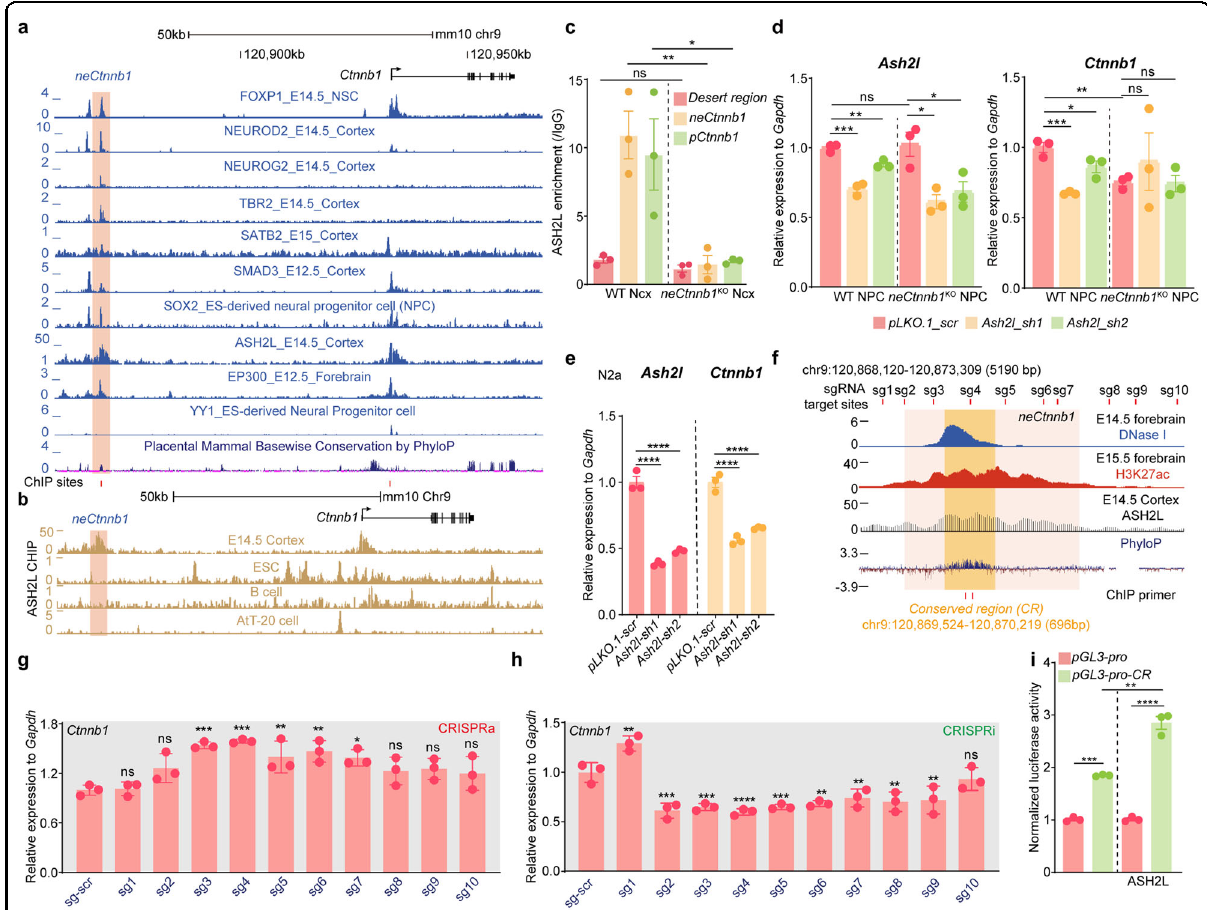
Fig. 5 ASH2L associates with neCtnnb1 and pCtnnb1 to regulate Ctnnb1 ’ s transcription. a ChIP-seq tracks for enrichment of indicated trans - acting factors in neCtnnb1 in developing Ncx. neCtnnb1 is highlighted. b ChIP-seq tracks for ASH2L in indicated murine cells. neCtnnb1 is highlighted. c ChIP-qPCR of E15.5 WT and neCtnnb1 KO Ncx using an anti-ASH2L antibody. n = 3 for WT Ncx and n = 3 for neCtnnb1 KO Ncx. Each point represents an individual brain. d RNA levels of Ash2l (left) and Ctnnb1 (right) in WT and neCtnnb1 KO neocortical NPCs transfected with indicated vectors for two days. NPCs were derived from E12.5 Ncx. n = 3 for WT brains and n = 3 for neCtnnb1 KO brains. Each point represents an individual brain. e RNA levels of Ash2l (left) and Ctnnb1 (right) in Neuro-2a cells transfected with indicated vectors for two days. Each point represents an independent experiment. f Schematic representation the location of neCtnnb1 (pink shading) and conserved region (orange shading) marked by enrichment of H3K27ac, DNase I hypersensitivity and ASH2L in E14.5 brains. Data were obtained from ENCODE. Locations of sgRNA target sites and ChIP primer were indicated. g , h RNA levels of Ctnnb1 in Neuro-2a cells transfected with indicated CRISPRa ( g ) and CRISPRi ( h ) vectors for two days. Each point represents an independent experiment. i Luciferase reporter assay in Neuro-2a cells transfected with indicated vectors for two days. Each point represents an independent experiment. Quanti fi cation data are shown as means ± SEM. Statistical signi fi cance was determined using two-way ANOVA followed by Sidak ’ s multiple comparisons test. ( c , d , e and i ); or using one-way ANOVA analysis ( g and h ). *P < 0.05, **P < 0.01, ***P < 0.001, and ****P < 0.0001. ns, not signi fi